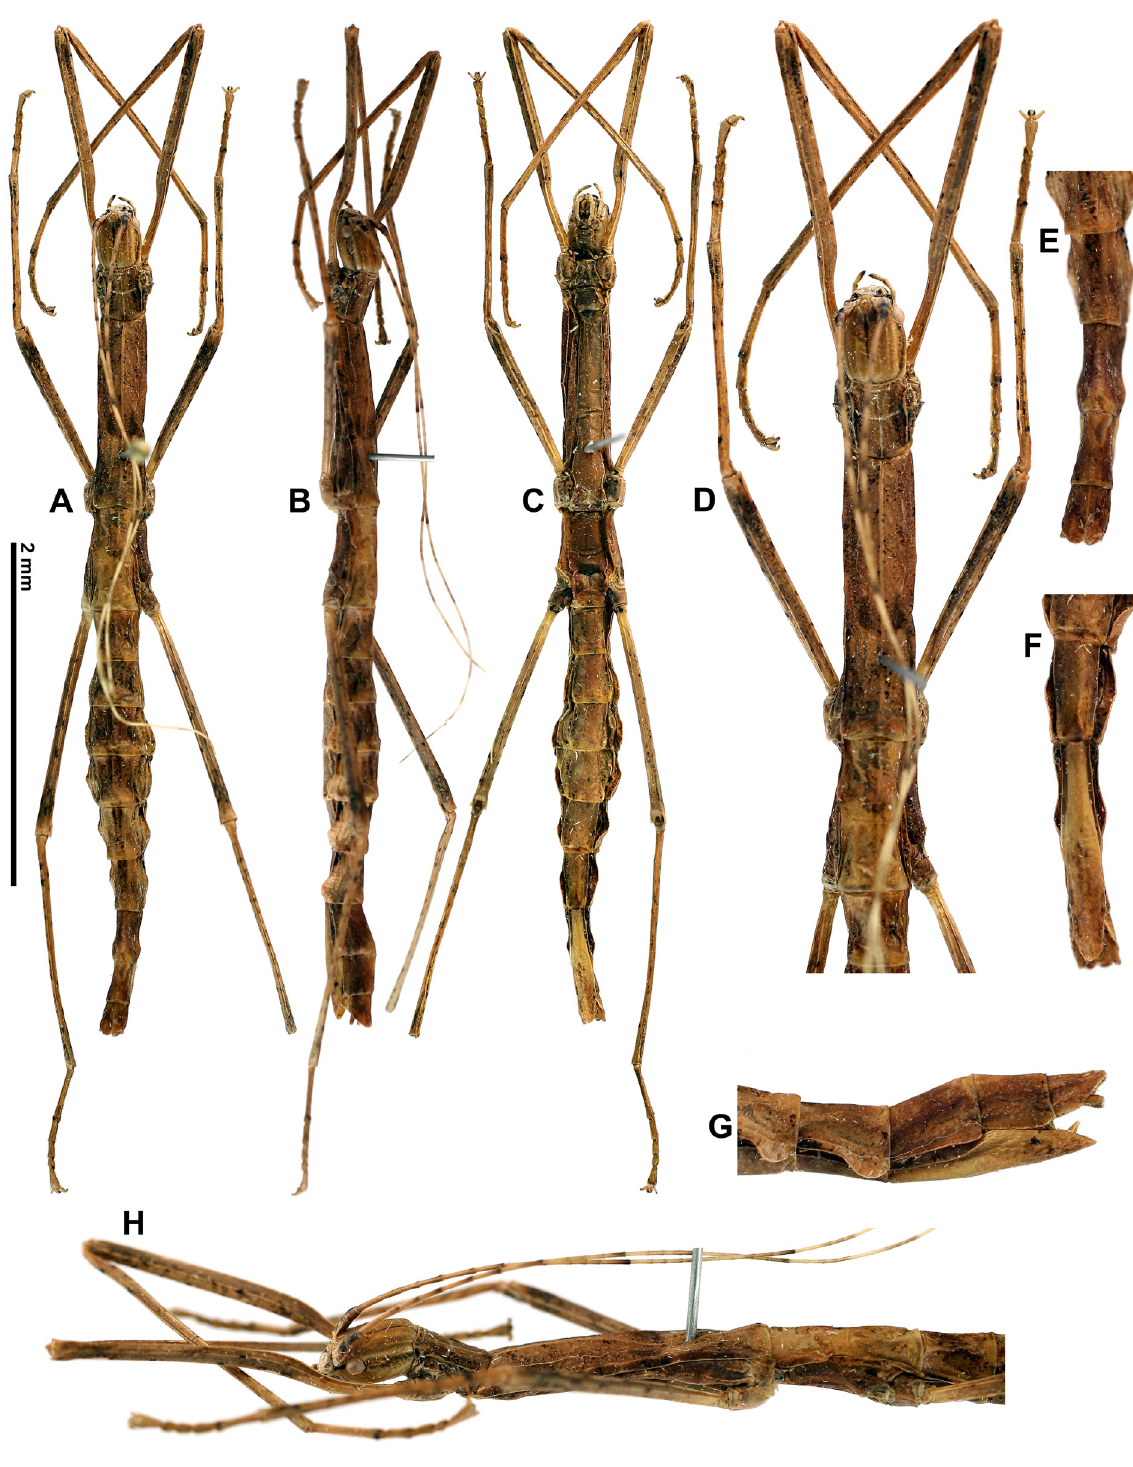
Fig. 3. Otraleus applai sp. nov., ♀, paratype. A . Habitus, dorsal view. B . Habitus, lateral view. C . Habitus, ventral view. D . Anterior part of body, dorsal view. E . Apex of abdomen, dorsal view. F . Apex of abdomen, ventral view. G . Apex of abdomen, lateral view. H . Anterior part of body, lateral view. D–H: not to